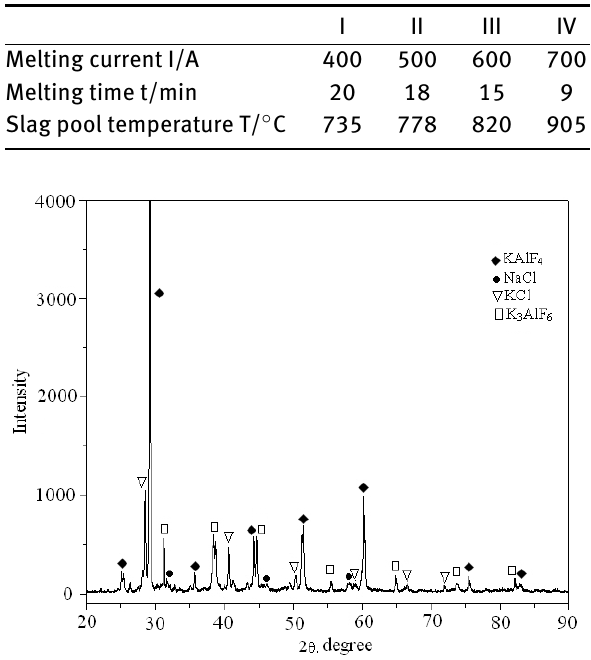
Figure 7: XRD pattern of slag crust on the surface of 5 wt% TiB 2 /Al ingot prepared at